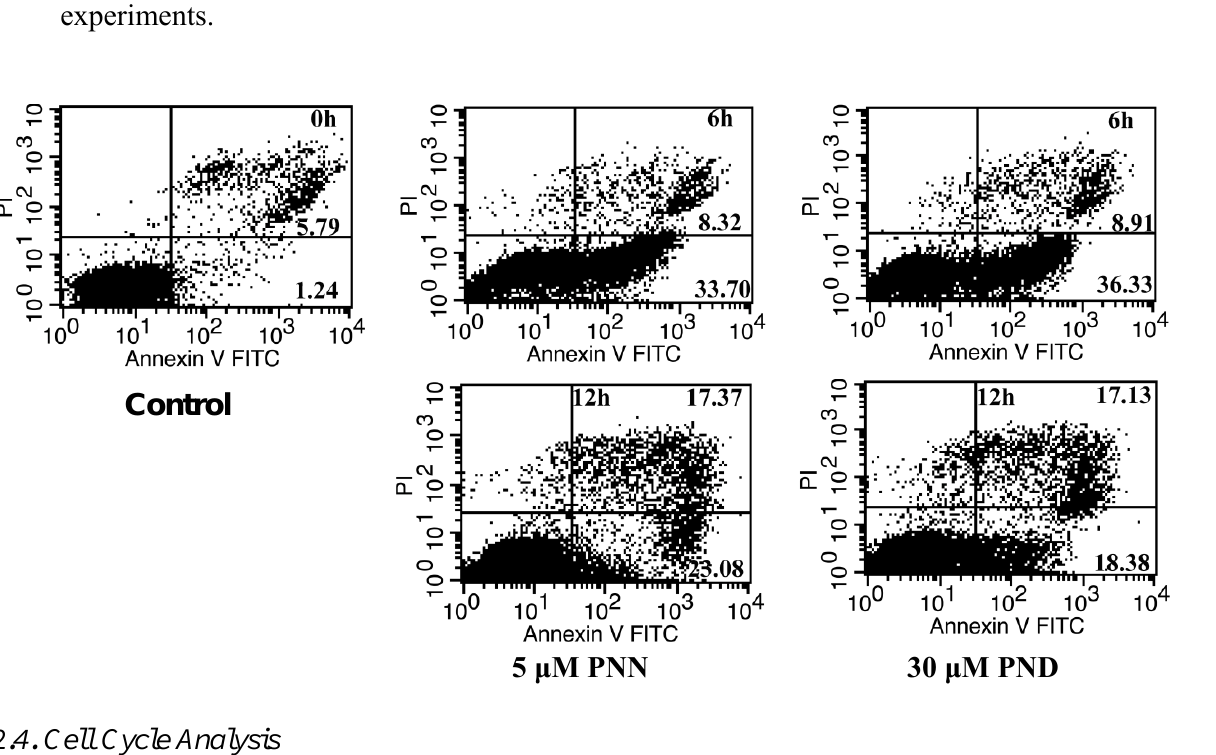
Figure 4. Detection of cell apoptosis using flow cytometry after annexin V-FITC/PI staining. Lower left quadrant, viable cells (annexin V − /PI − ); lower right quadrant, early apoptotic cells (annexin V+/PI − ); upper right quadrant, late apoptotic cells (annexin V+/PI+); upper left quadrant, necrotic cells (annexin V − /PI+). Cells were exposed to 5 μ M PNN or 30 μ M PND for 0, 6 and 12 h. The numbers in panel represent the percentage of annexin-V+/PI − and annexin-V+/PI+ cells. Data were representative of three independent